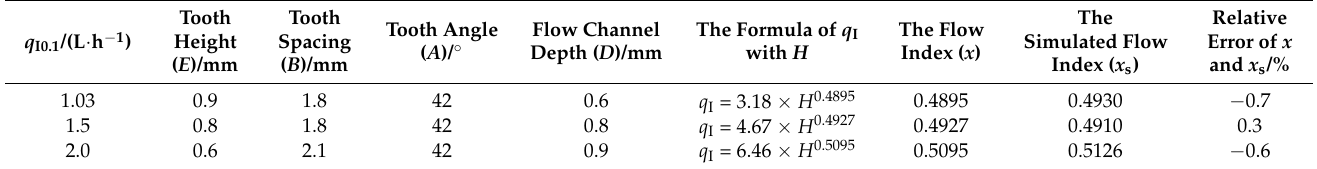
Table 8. Optimal combination of flow channel structural parameters for different flow rates at H = 0.1 MPa ( q I0.1